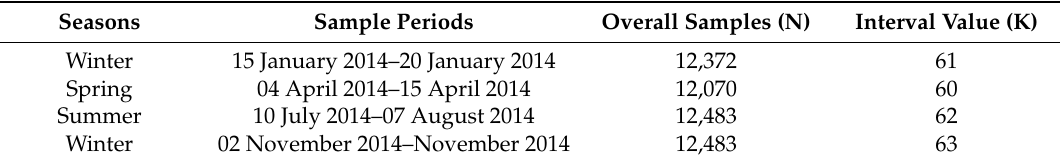
Figure 4. The process of K-sampling for microblog corpus collection. Table 1. Sampling parameters for corpus collection in different seasons.